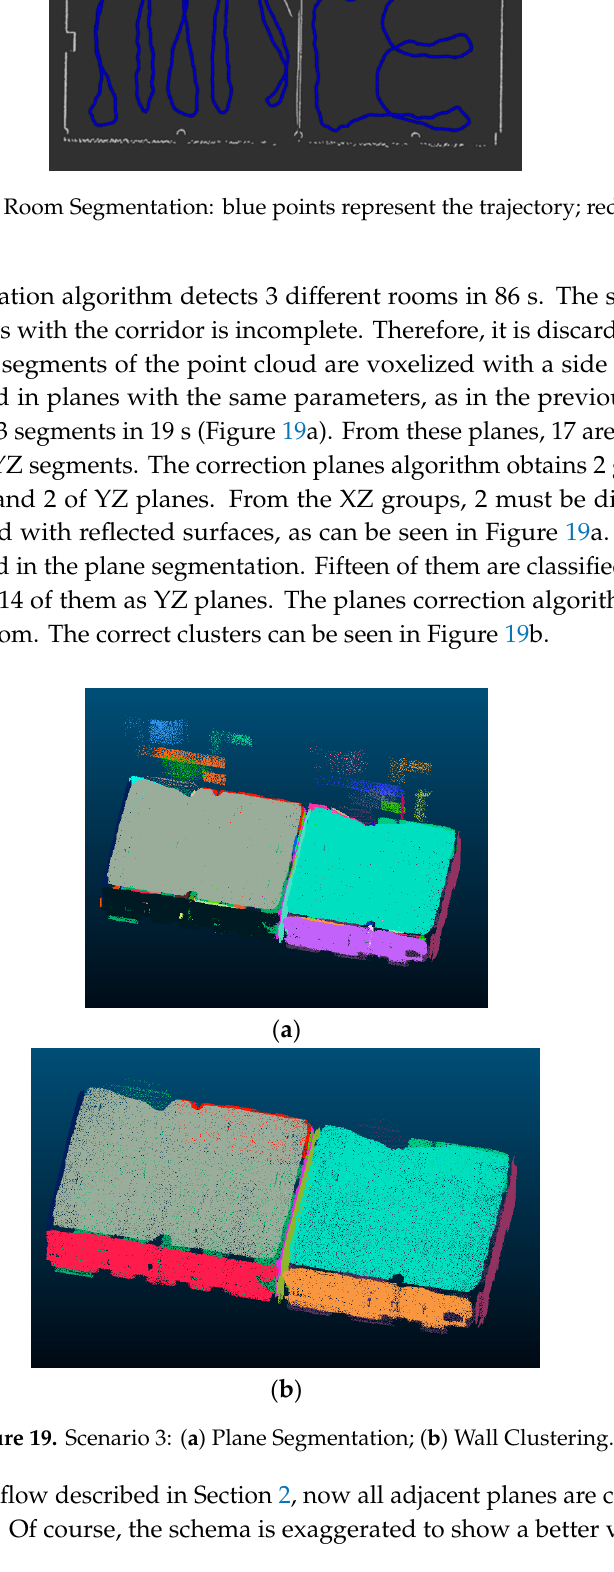
( b ) Figure 20. Schema of the correction of planes: ( a ) Before the correction; ( b ) After the correction. At this point, the planes of each room are intersected. With 6 planes per room, 8 intersection points are obtained, which are the vertexes of each room. After generating the gbXML schema with these data, one last correction is needed, as explained in Section 1: if any wall corresponding with the intersection wall between two rooms is duplicated, one of the polygons is deleted for this wall and